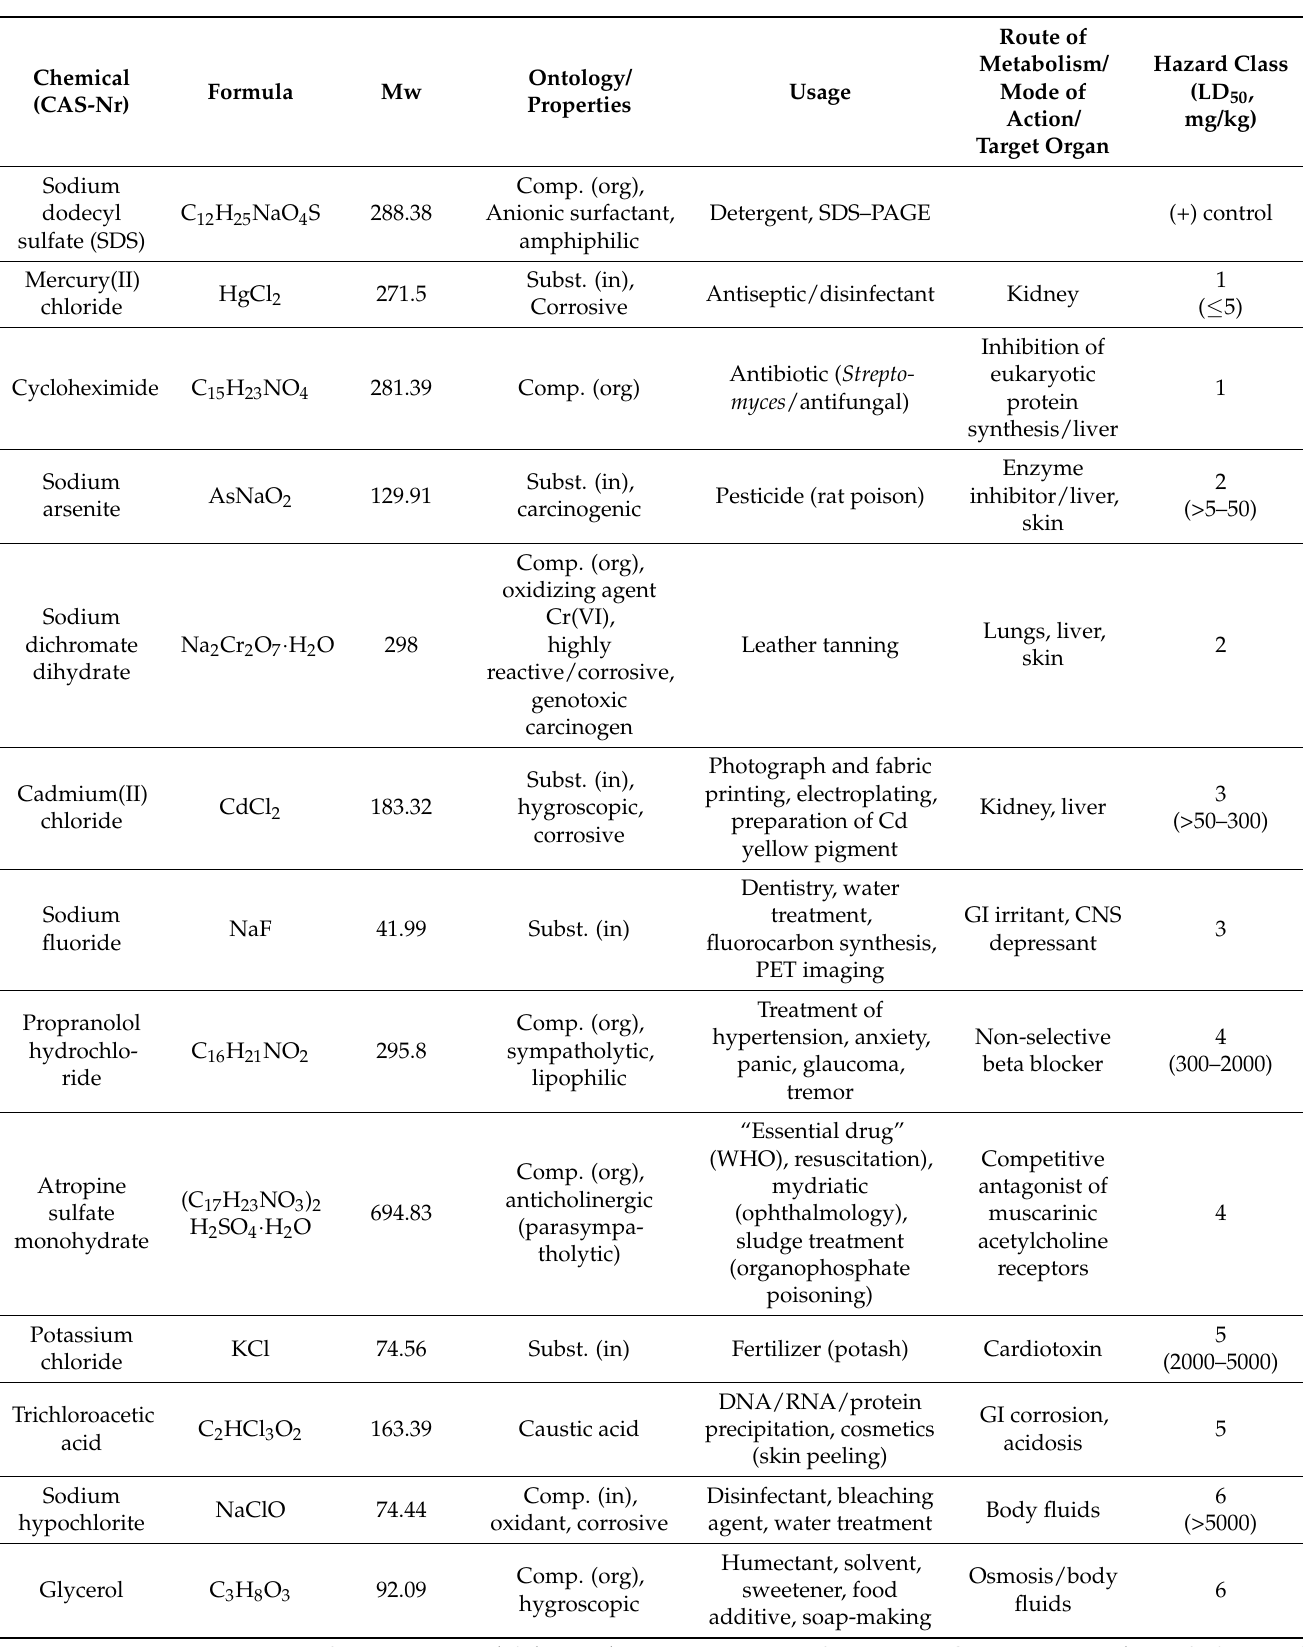
Table 1. Properties of the 12 chemicals used in the present